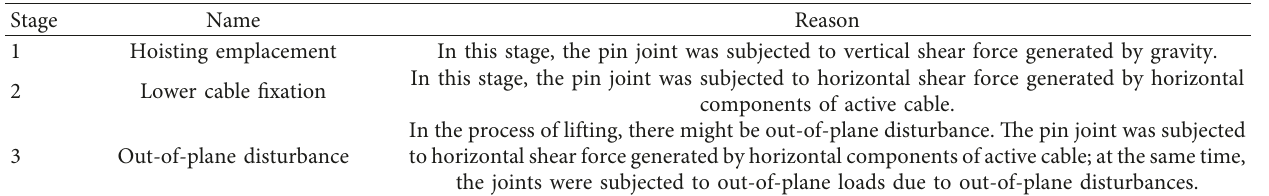
Figure 10: The new scheme of connection. (a) 3D schematic. (b) Initial state of the connection. (c) Completion status of the connection. Table 1: Division of construction